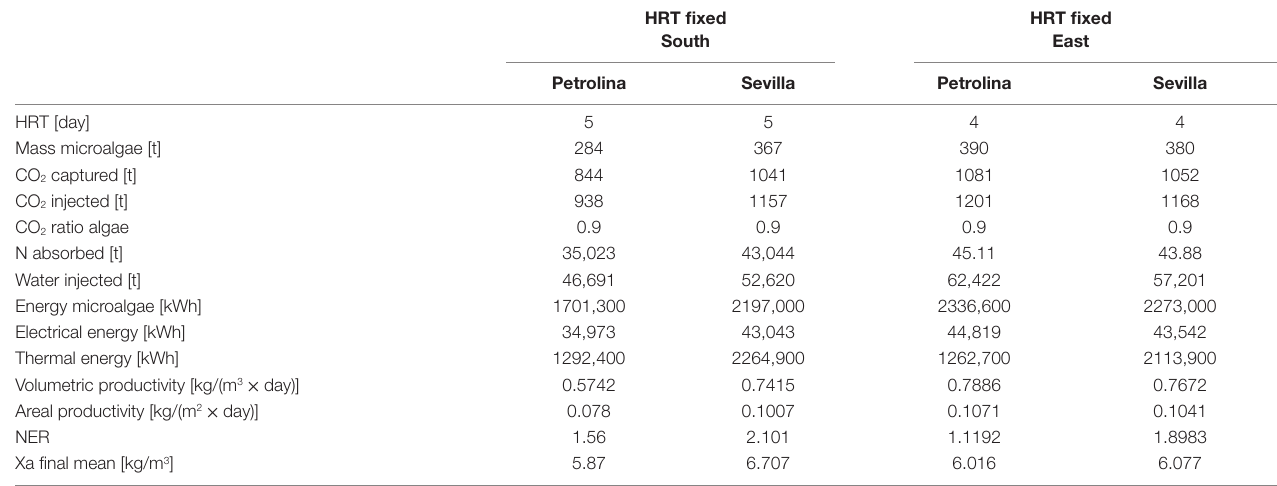
TaBle 9 | results from flat panel simulation using the second strategy, meaning that input microalgae concentration and hrT are known.